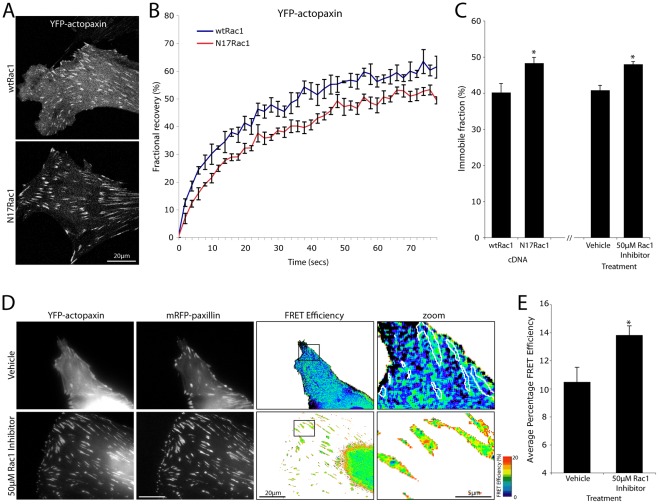
Paxillin is immobilized in adhesions upon Rac1 inhibition through an increased interaction with actopaxin.(A) Representative images of YFP-actopaxin-expressing NIH 3T3 cells used for FRAP analyses. YFP-actopaxin exhibits robust adhesion localization but a reduction in non-adhesion localization upon Rac1 inhibition. (B) Compiled FRAP recovery curves for YFP-actopaxin in the presence of wtRac1 or N17Rac1. Error bars represent standard error of the mean and n = 3 individual experiments. (C) Immobile fraction quantitation for YFP-actopaxin with wtRac1, N17Rac1 and ±50 μM Rac1inhibitor. Error bars are standard error of the mean from a minimum of n = 3 individual experiments. (D) Images and (E) quantitation of YFP-actopaxin and mRFP-paxillin FRET in adhesion contacts upon Rac1 inhibition. Error bars are standard error of the mean and are from all adhesions from a minimum of 11 cells from 3 individual experiments. * = p<0.05.